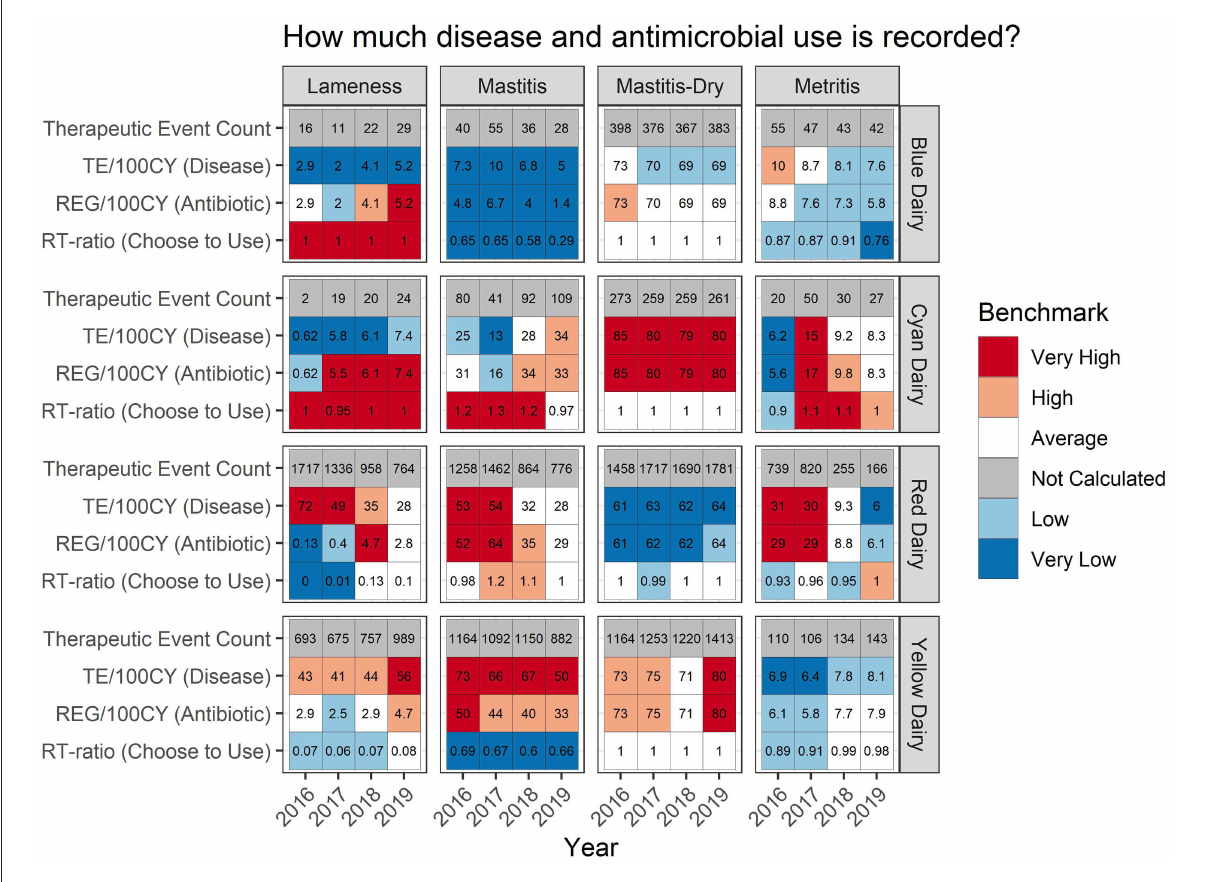
of where a point falls in relation to the dashed line in the scatter plots. For example, in the mastitis plot (Figure 2A) Blue Dairy and Yellow Dairy fall below the dashed line, indicating that on average not all mastitis TE include an